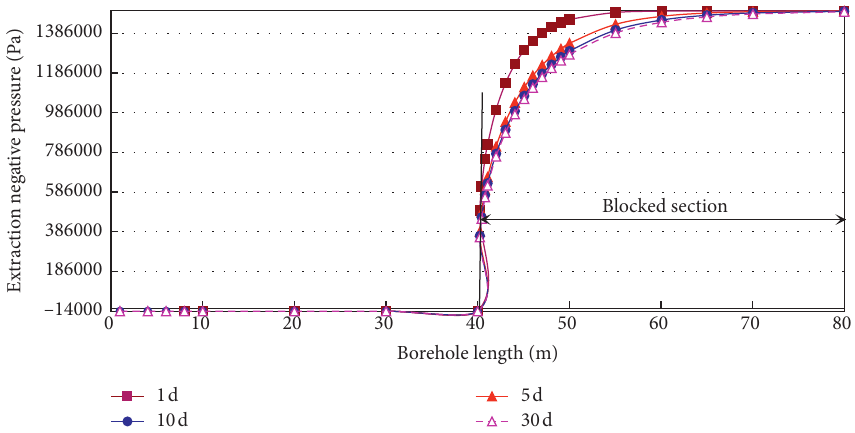
Figure 10: The gas extraction pressure distribution of plug hole.